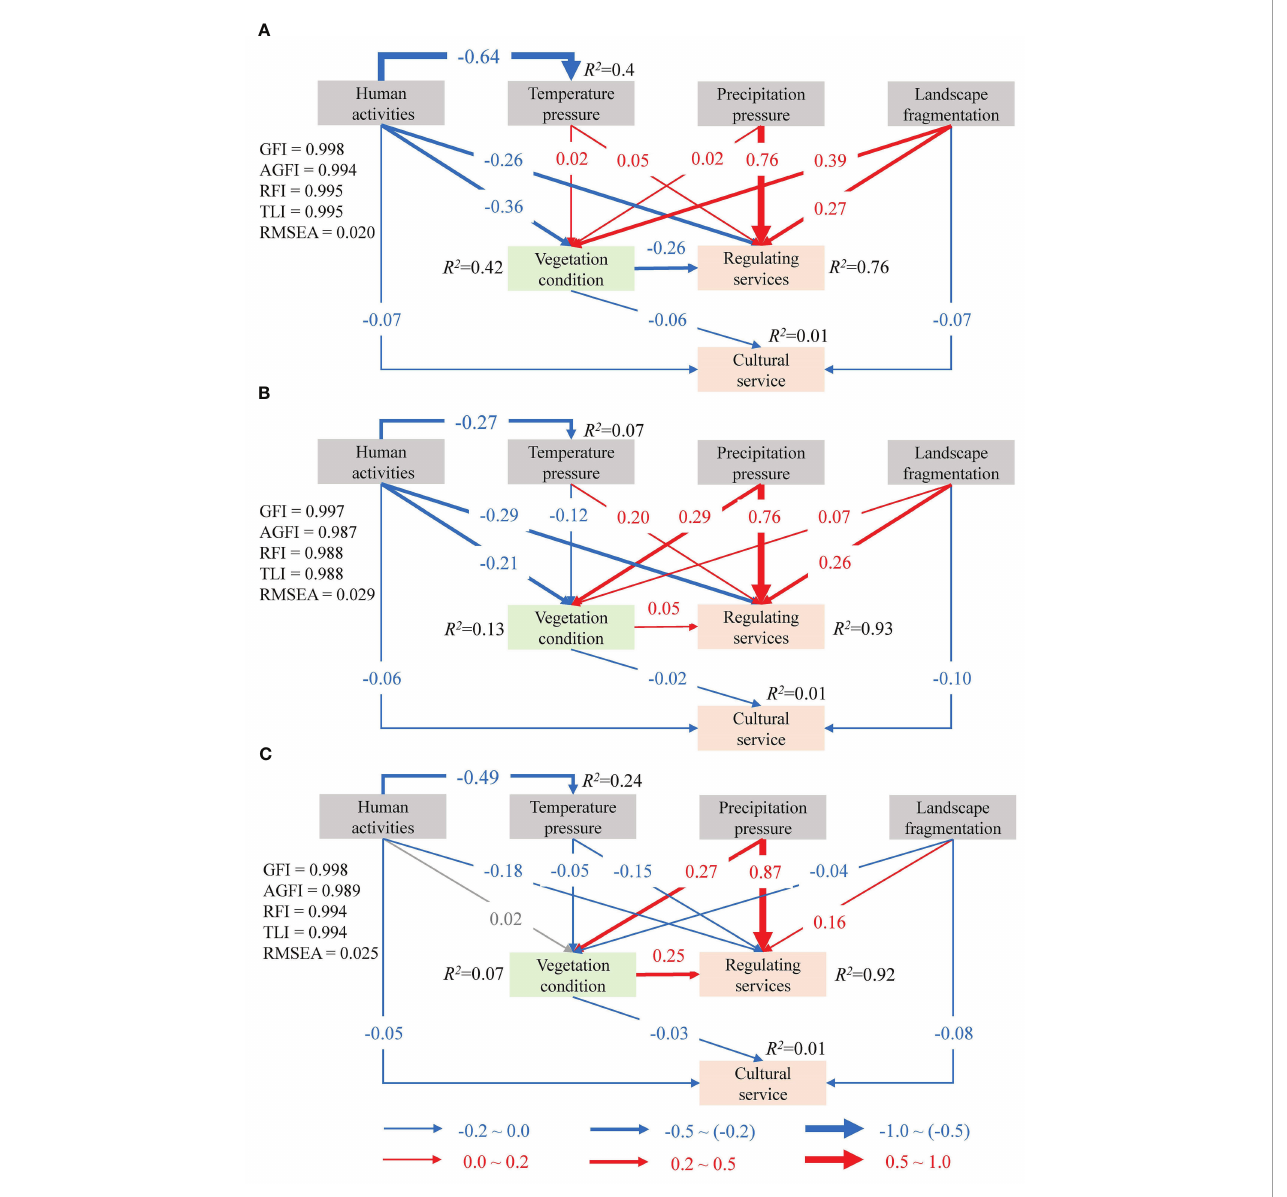
FIGURE 7 Impacts of pressures and vegetation condition on ESs in 2000 (A) , 2010 (B) and 2019 (C) . Blue and red arrows indicate signi fi cant negative and positive impacts ( p ≤ 0.01), respectively; Grey arrow indicates that the relationship is not signi fi cant; R 2 indicates the proportion of variance